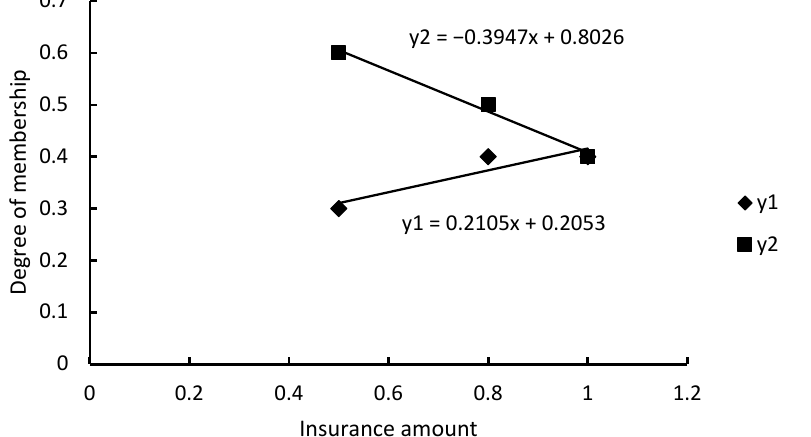
Figure A19. Single factor evaluation for the index of insurance amount (0.5–1 (inclusive) ten thou- sand yuan).